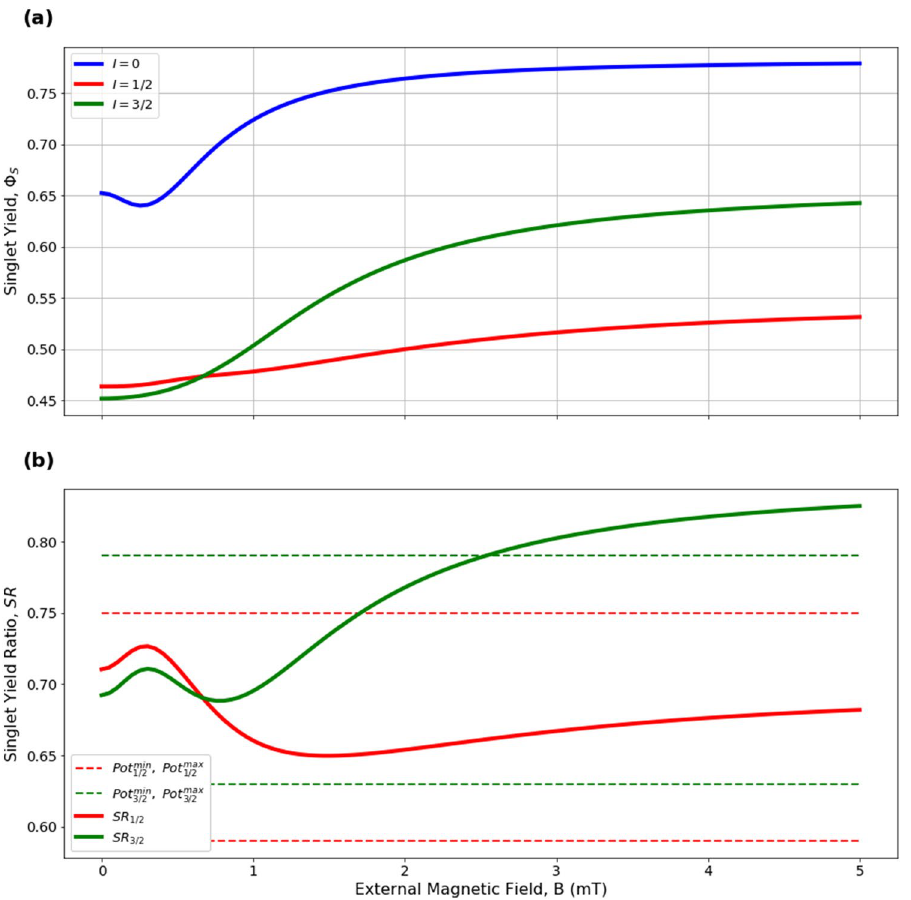
Figure 8. The dependence of the singlet yield and singlet yield ratio on an external magnetic field, with B ∈ [ 0, 5000 ] µ T, k = 5.5 × 10 7 s − 1 , r = 5.0 × 10 6 s − 1 , and hyperfine constants of a ′ 1896 µ T, a ′ 347 µ T. 1 = 2 = The singlet yield and the singlet yield ratio SR are calculated using a 1 = (γ n / | γ 129 Xe | )γ e a ′ 1 , where the magnitude of the isotopic nuclear gyromagnetic correction factor, (γ n / | γ 129 Xe | ) , is normalized for 129 Xe. (a) The absolute singlet yield using xenon isotopic nuclear spin values of I ∈ { 0, 1 / 2, 3 / 2 } . (b) The relative singlet yield ratios I = 0 being normalized to SR SR SR 0 = 1 . Values of SR and Pot 1 / 2 and 3 / 2 with the singlet yield ratio of spin agree for B ∈ [ 0, 2525 ] µ